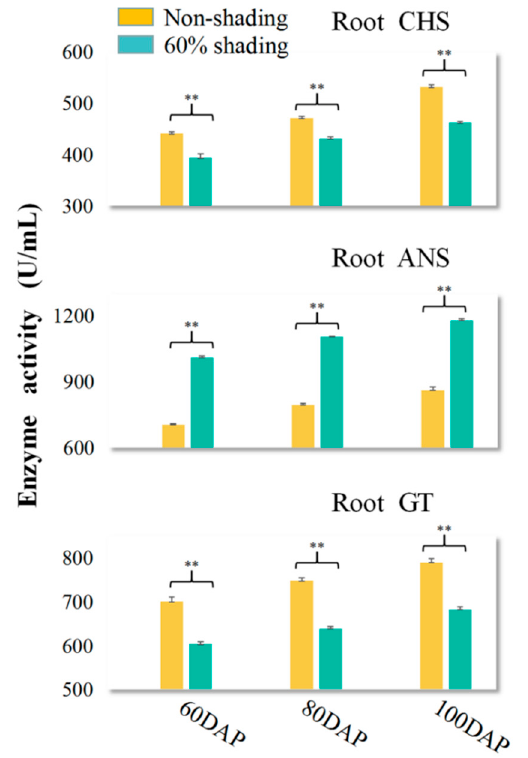
Figure 6. ELISA analysis of the activities of three key enzymes, CHS, ANS and GT, of the flavonoid pathway in PSP storage roots of 60 DAP, 80 DAP and 100 DAP under shaded conditions. Data represent the mean ± SD of three individual plants (n = 3) with main storage roots mixed in each plant. The asterisks represent significant differences by Student’s t -test at p < 0.01 (**), respectively. The columns of enzyme activities from PSP storage roots under 60% shading treatment are shown with green filling and those under nonshaded conditions are shown with yellow filling. chalcone synthase, CHS; anthocyanidin synthase, ANS; glycosyltransferase, GT; purple-fleshed sweet potato,